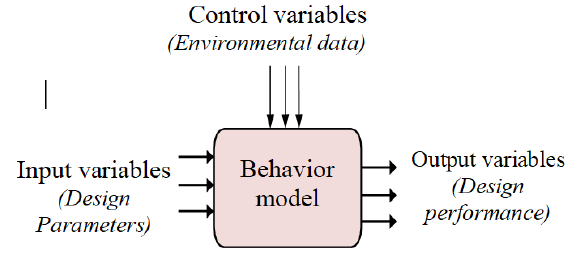
Figure 2. Formalization of a behavior model for product